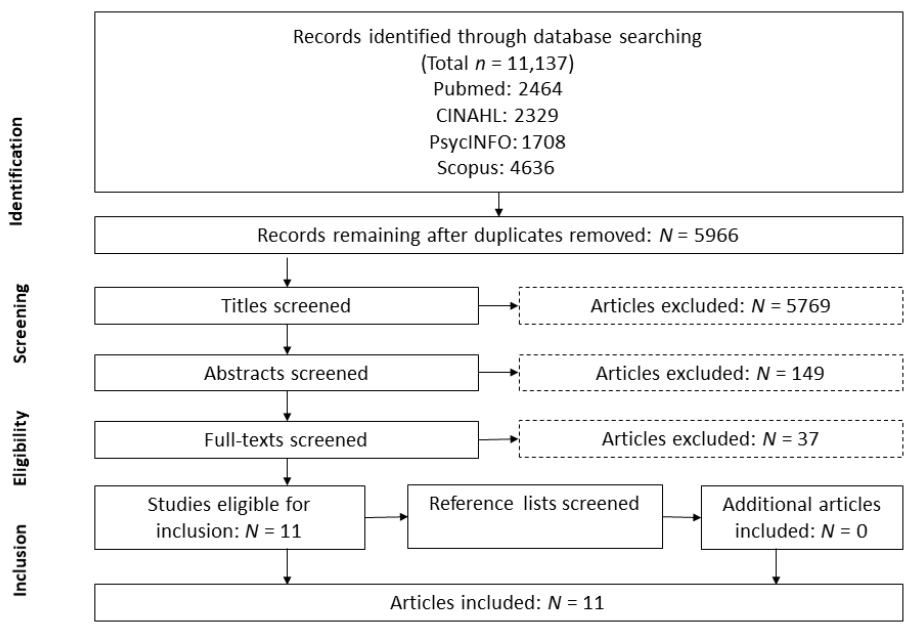
Figure 1. Screening